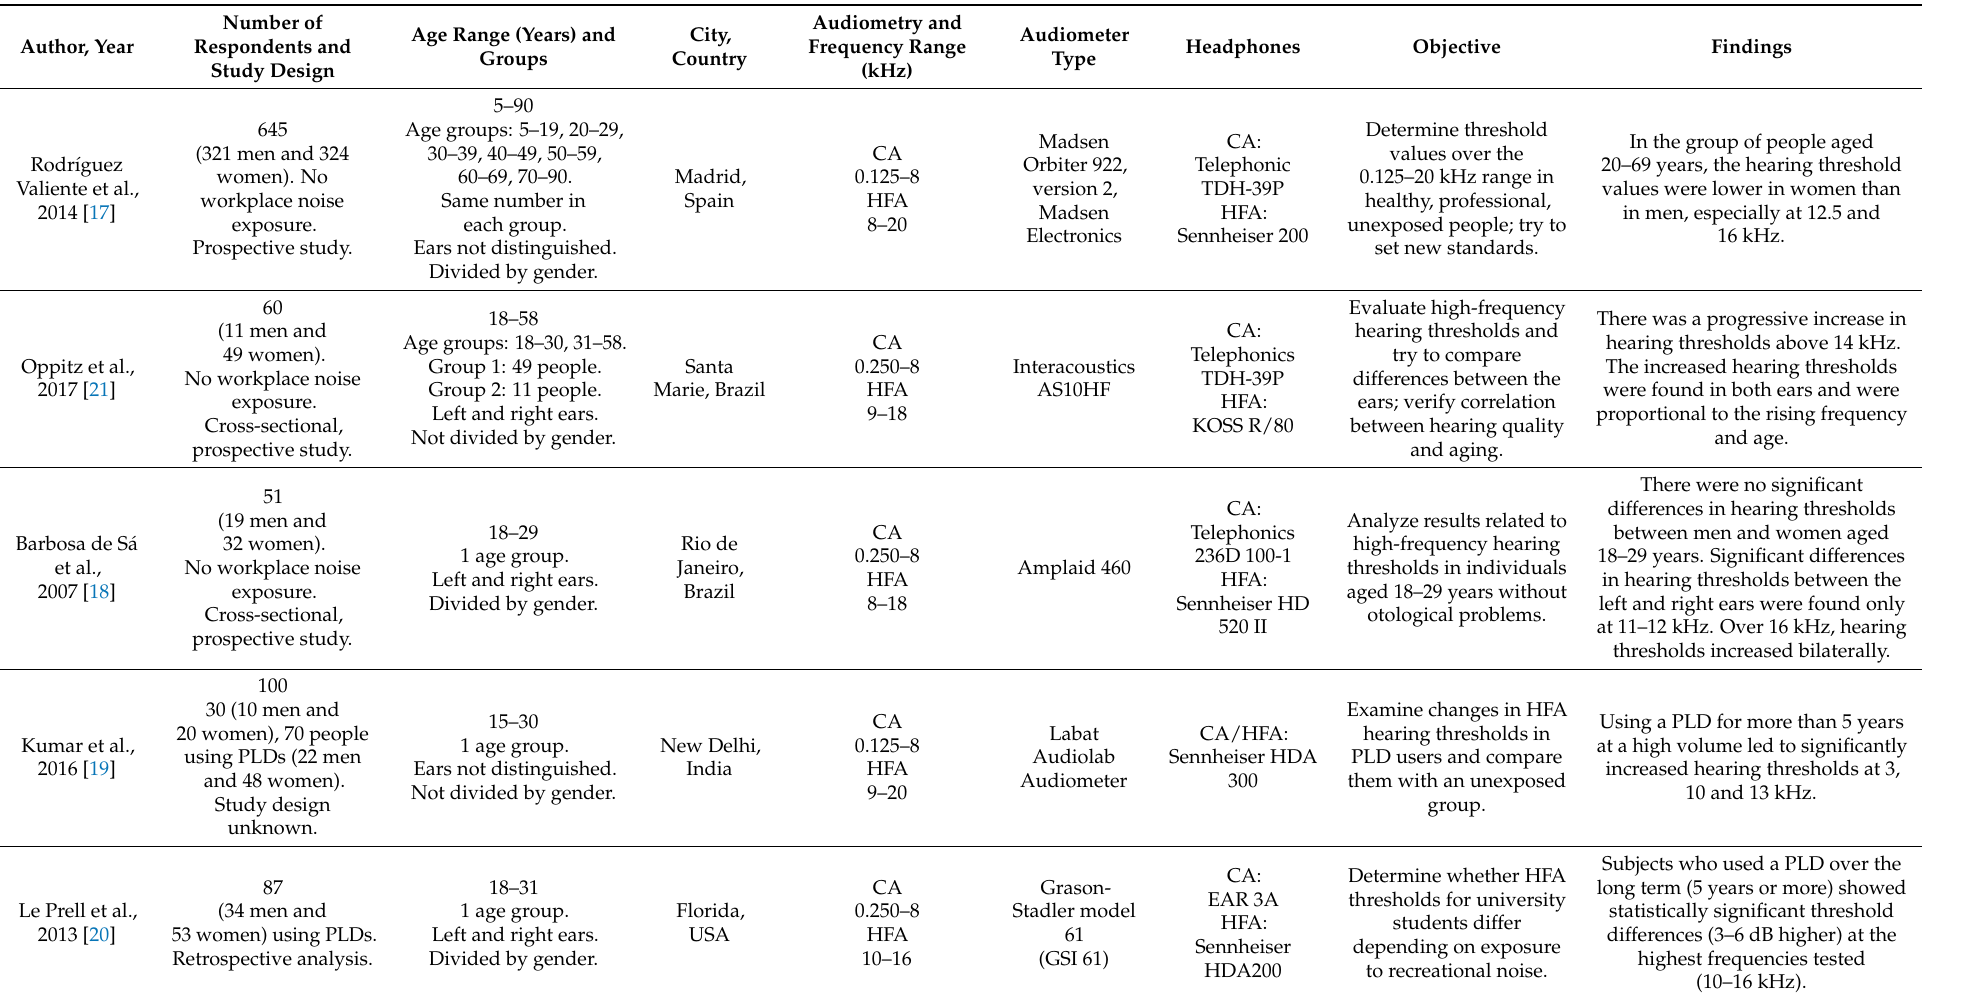
Table 1. Overview of the selected articles on hearing loss and high-frequency audiometry in populations not exposed to workplace